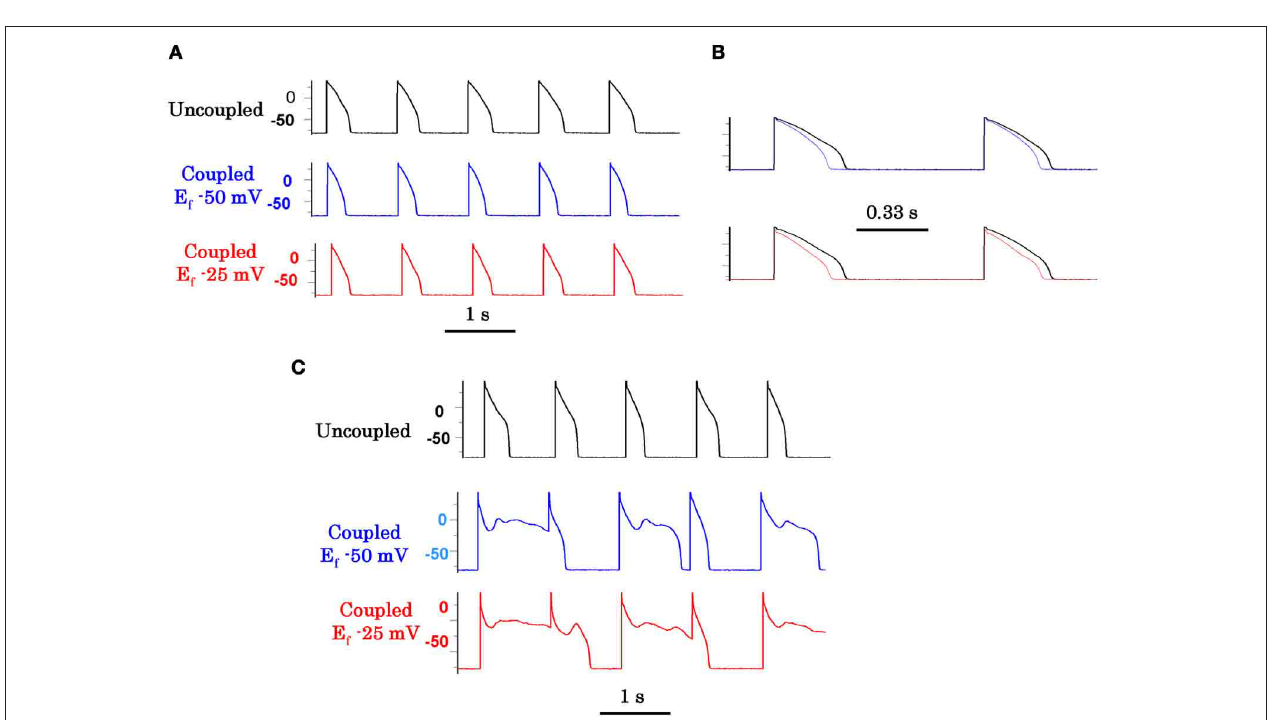
young and aged myocytes manifested EADs and triggered activity with significant differences between the two aged groups (from Bapat et al., 2012).